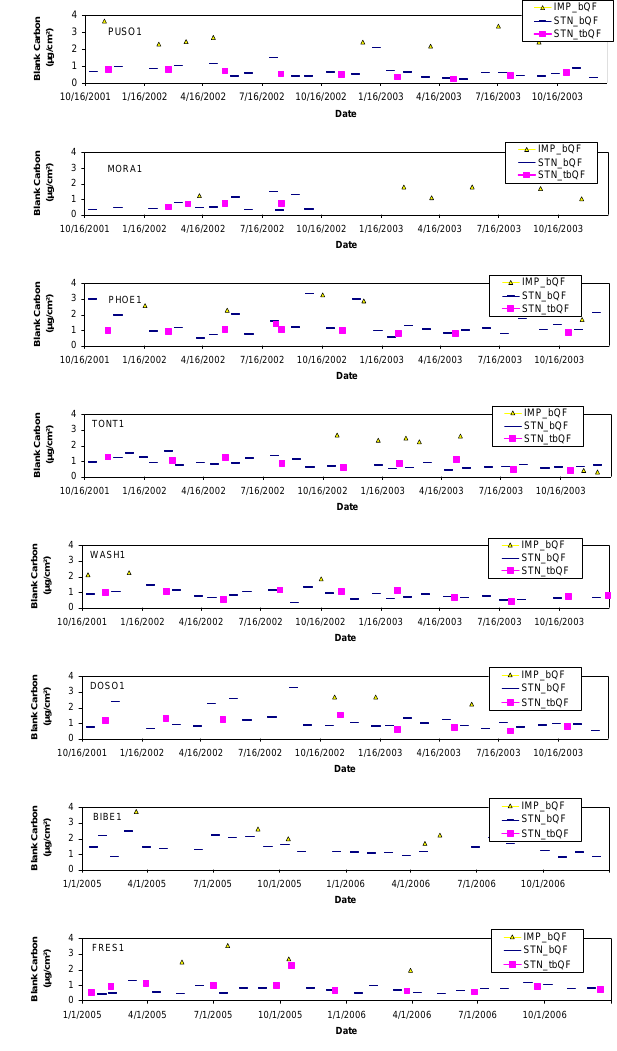
Figure 6. Fig. 6. Time series of IMPROVE and STN/CSN blank TC concentrations at eight collocated sites from 1 January 2005 to 31 December 2006 (IMP bQF: IMPROVE field blanks; STN bQF: STN/CSN field blanks; STN tbQF: STN/CSN trip blanks).